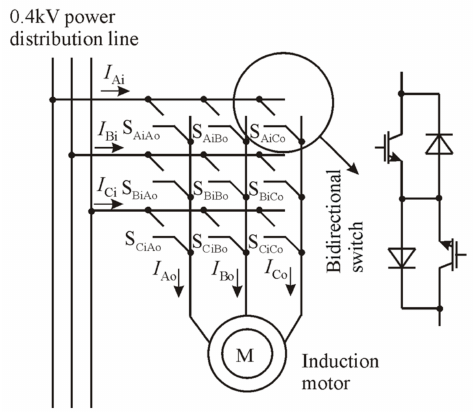
Figure 7. Functional diagram of MC-based induction motor VFD. Table 4. Active combinations created by nine bidirectional